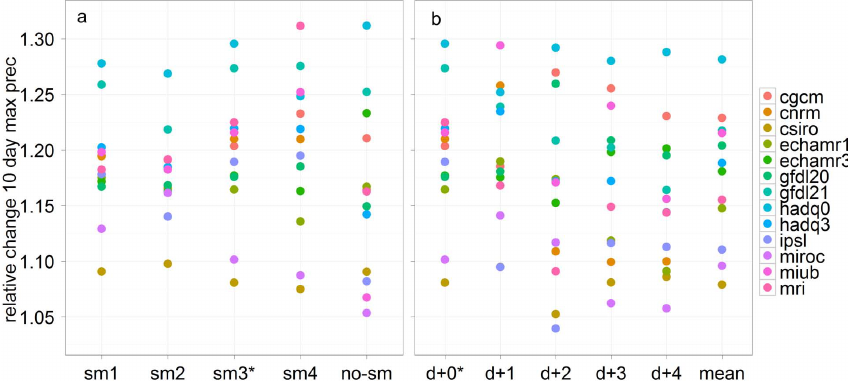
Fig. 3. Relative changes of the 10-yr return level of the 10-day basin-average precipitation in the winter half-year (October–March) for each GCM. Panel (a) shows the effect of different choices for temporal smoothing: two 5-month moving averages with weights 1/16, 1/8, 3/8, 1/8, 1/16 (sm1) and 1/8, 1/4, 1/4, 1/4, 1/8 (sm2), two 3-month moving averages with weights 1/4, 1/2, 1/4 (sm3) and 1/8, 3/4, 1/8 (sm4) and no temporal smoothing (no-sm). Panel (b) shows the effect of shifting the 5-day period. Mean indicates the mean of the relative changes of the 5 different shifts for each GCM simulation. The asterisk indicates the type of smoothing (a) or the 5-day period (b) used in this study.